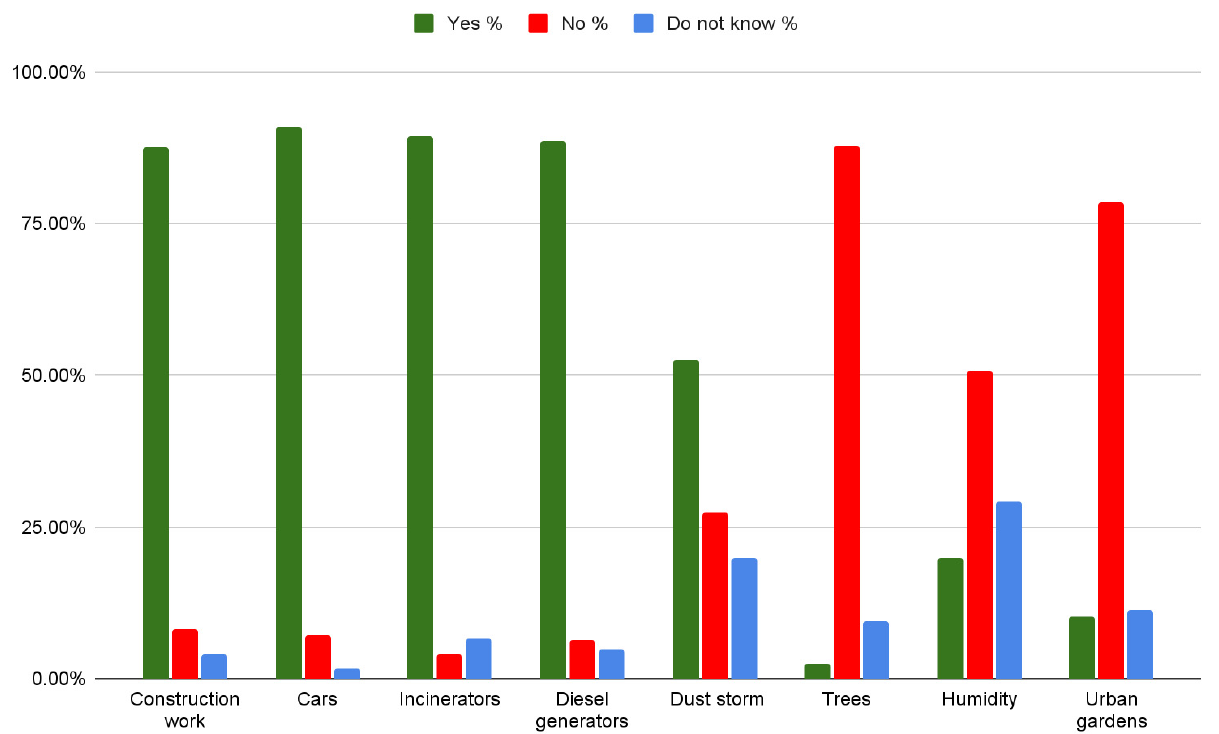
Figure 1. Answers to the question “Which of the below do you think are sources of air pollution?”